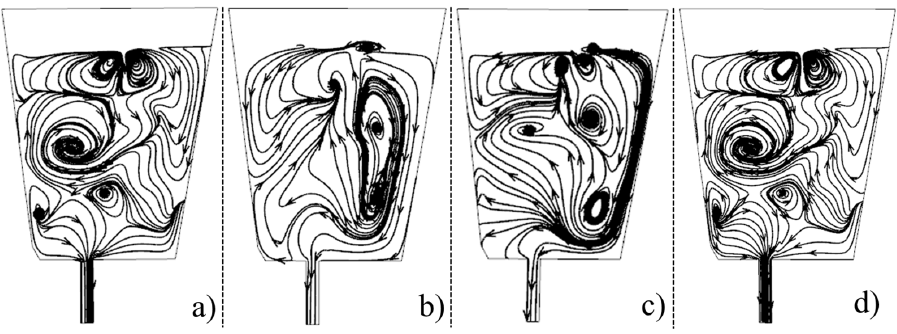
Figure 6. Streamline at plane 3 under different heating powers. ( a ) Without plasma heating, ( b ) 300 kW, ( c ) 500 kW and ( d ) 1000